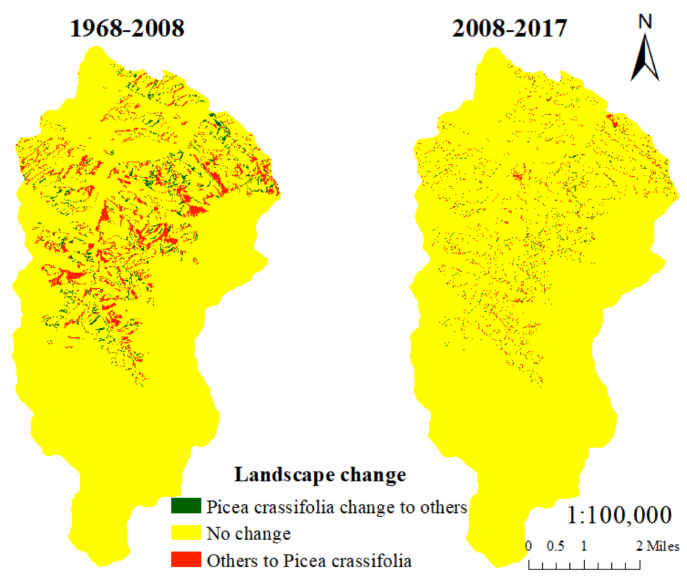
Figure 5. Area change of Picea crassifolia Kom. from 1968 to 2008 and 2008 to 2017 in the Dayekou watershed.